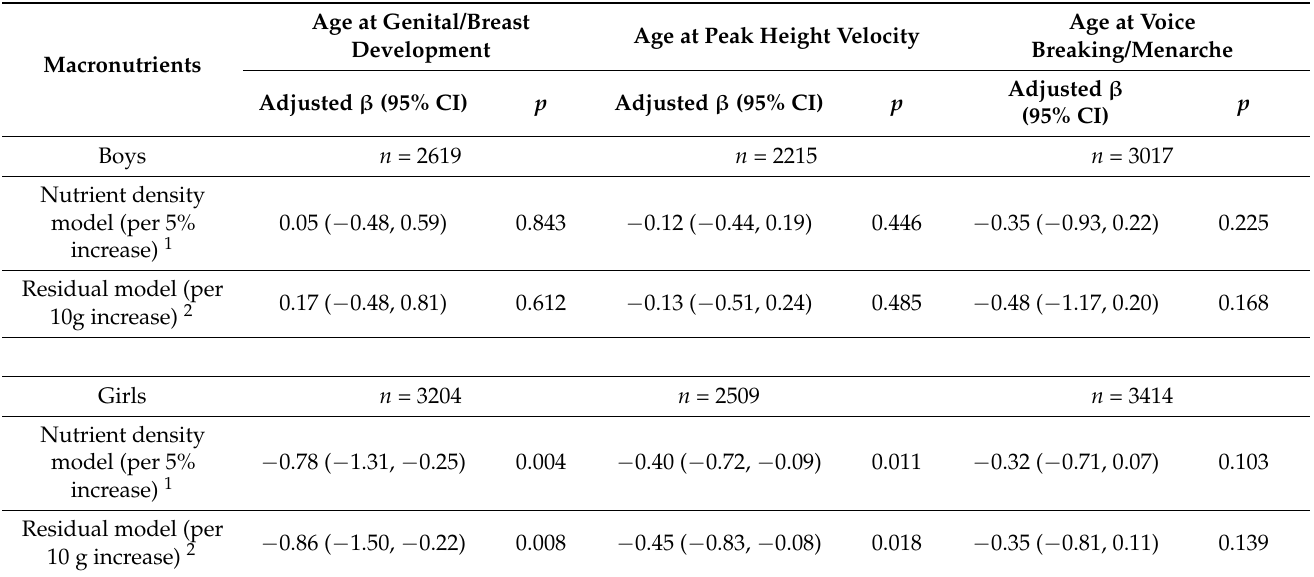
Table 2. Substitution of dietary polyunsaturated fat for saturated fat intake predicted at 6 years old and puberty timing in the ALSPAC